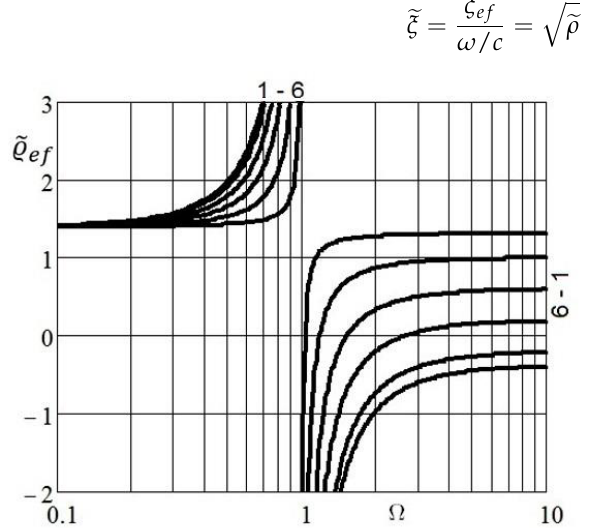
Figure 4. The dependence of the effective density 𝜚̃ 𝑒𝑓 on the frequency 𝛺 at different values of the parameter: 𝑚̃:1 − 𝑚̃ = 2; 2 − 𝑚̃ = 1; 3 − 𝑚̃ = 0.4; 4 − 𝑚̃ = 0.2; 5 − 𝑚̃ = 0.1;6 − 𝑚̃ = 0.07 .